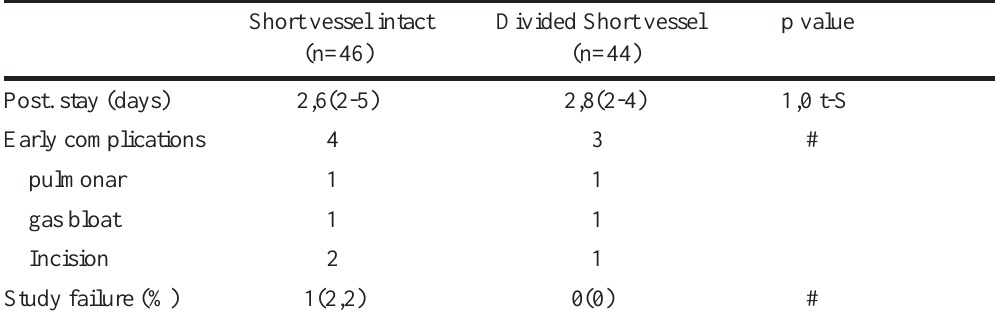
TABLE 3 - Postoperative course Short vessel intact Divided Short vessel